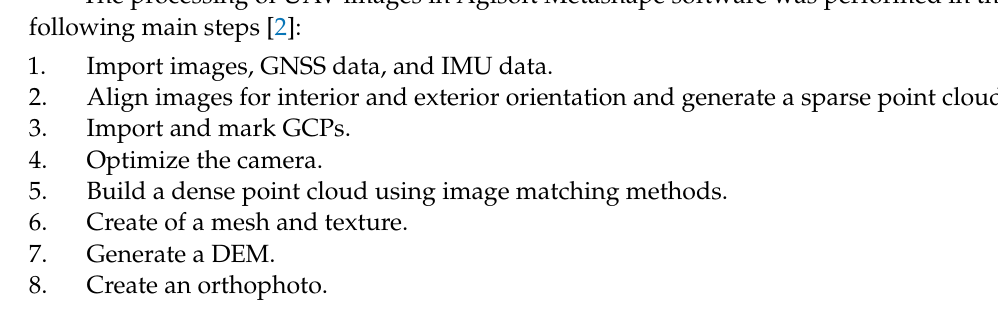
Table 2. Setting parameters of Agisoft Metashape used in this study.